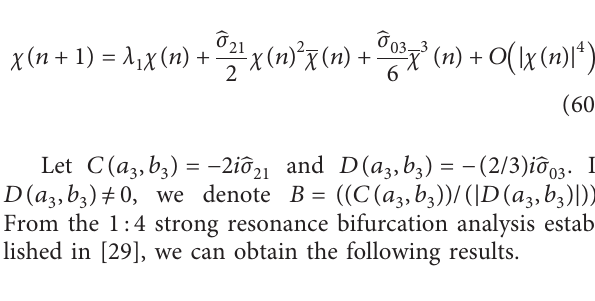
Figure 6: 1: 4 strong resonance bifurcation diagram at (0.627048, 0.671077): (a) in ( a − w ) plane with b � 17 . 42246 and (b) in ( b − a − w )